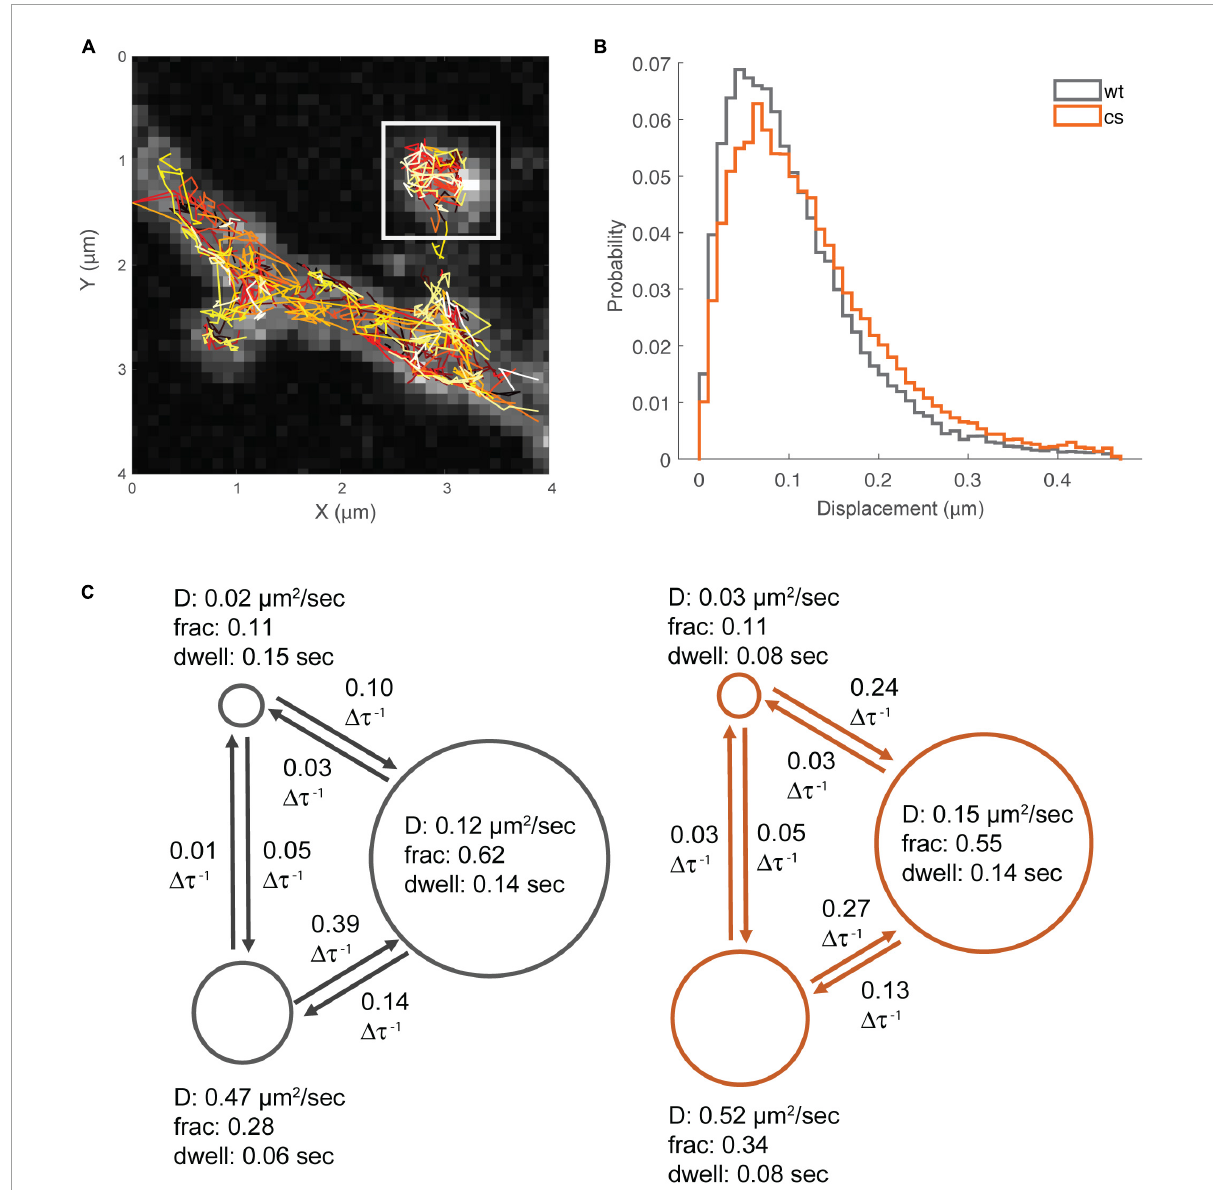
FIGURE7 Single-molecule tracking reveals multiple mobility states for AKAP79. (A) Example smt-PALM dataset, only trajectories from distinct spine heads were used for downstream analysis (white box). (B) Semi-quantitative analysis of single-step displacements. (C) Hidden-Markov analysis of trajectories, WT states/transitions are shown in gray, CS states/transitions shown in orange. Circle diameter is proportional to fraction occupancy. Other parameters are apparent diffusion coefficient, average molecular dwell time per state, and inter-state transition probability (per time-step, 22